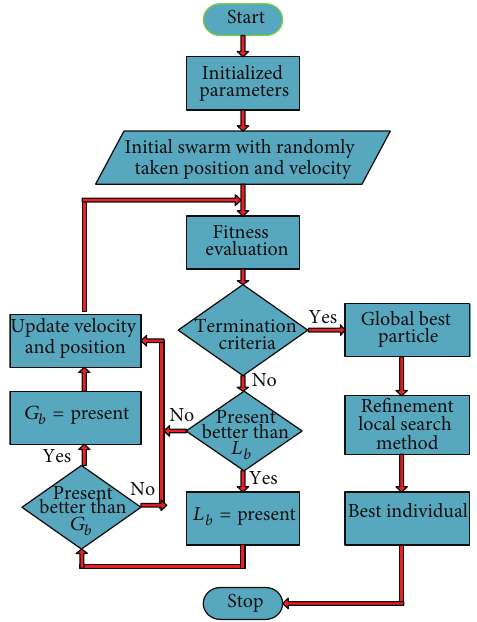
Figure 2: Generic flow diagram of Hybrid Particle Swarm Opti-